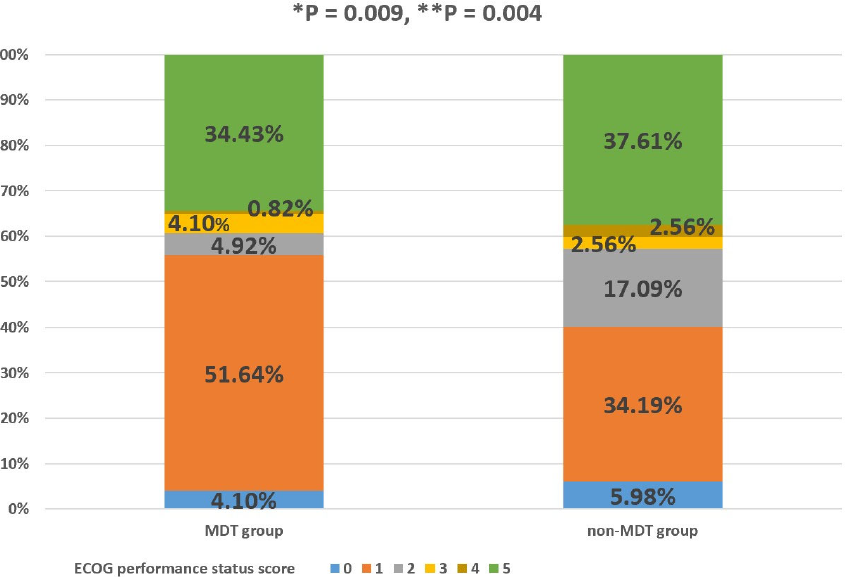
Figure 4. Percentage of MDT and non-MDT groups in each ECOG PS score category. “*” with respect to patients with advanced GISTs who died were also included; “**” with respect to GIST patients who died were excluded. p -value was determined using Fisher´s exact test.